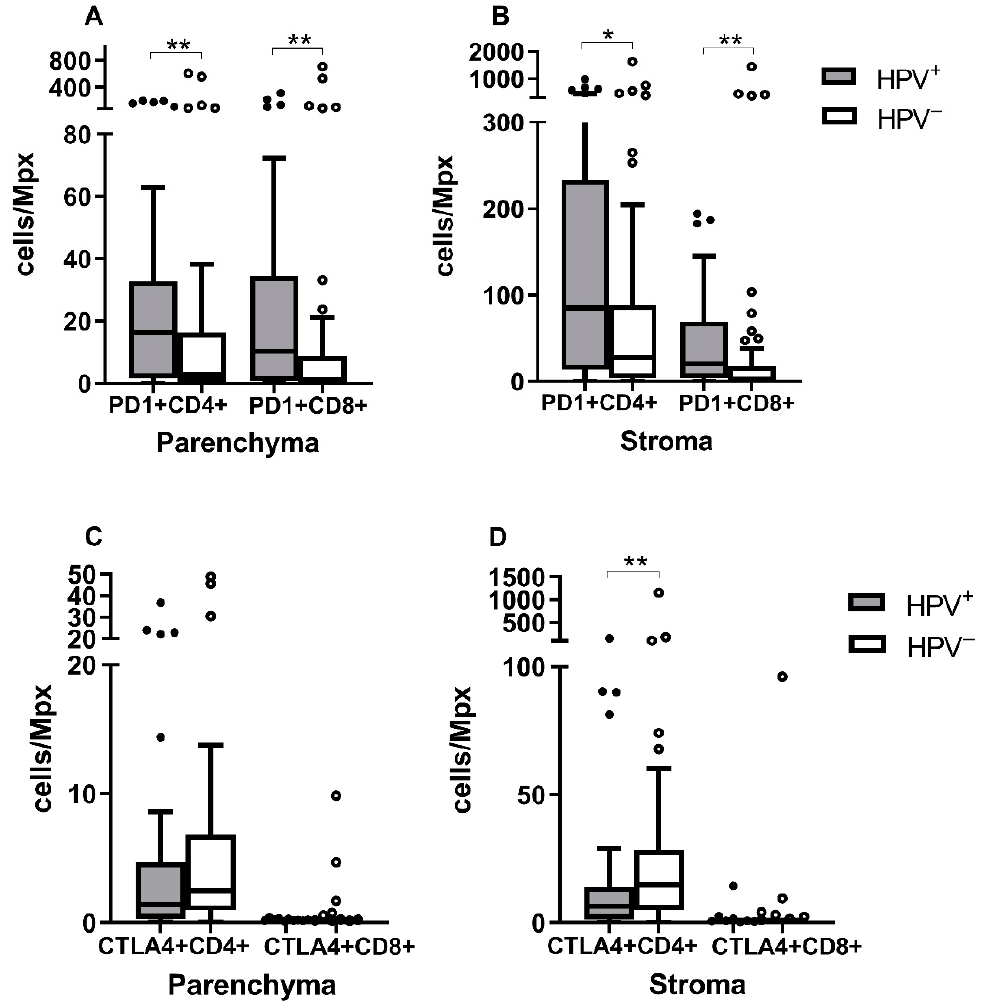
Figure 2. PD-1 + or CTLA4 + T lymphocyte infiltration in different compartments of the tumors of different etiology. The numbers of CD4 + and CD8 + T lymphocytes expressing the PD-1 molecule in ( A ) the parenchyma and ( B ) the stroma, and the numbers of CD4 + and CD8 + T lymphocytes producing the CTLA4 molecule in ( C ) the parenchyma and ( D ) the stroma were compared between groups. PD-1 expression was significantly higher in both compartments of HPV + tumors, while the CTLA4